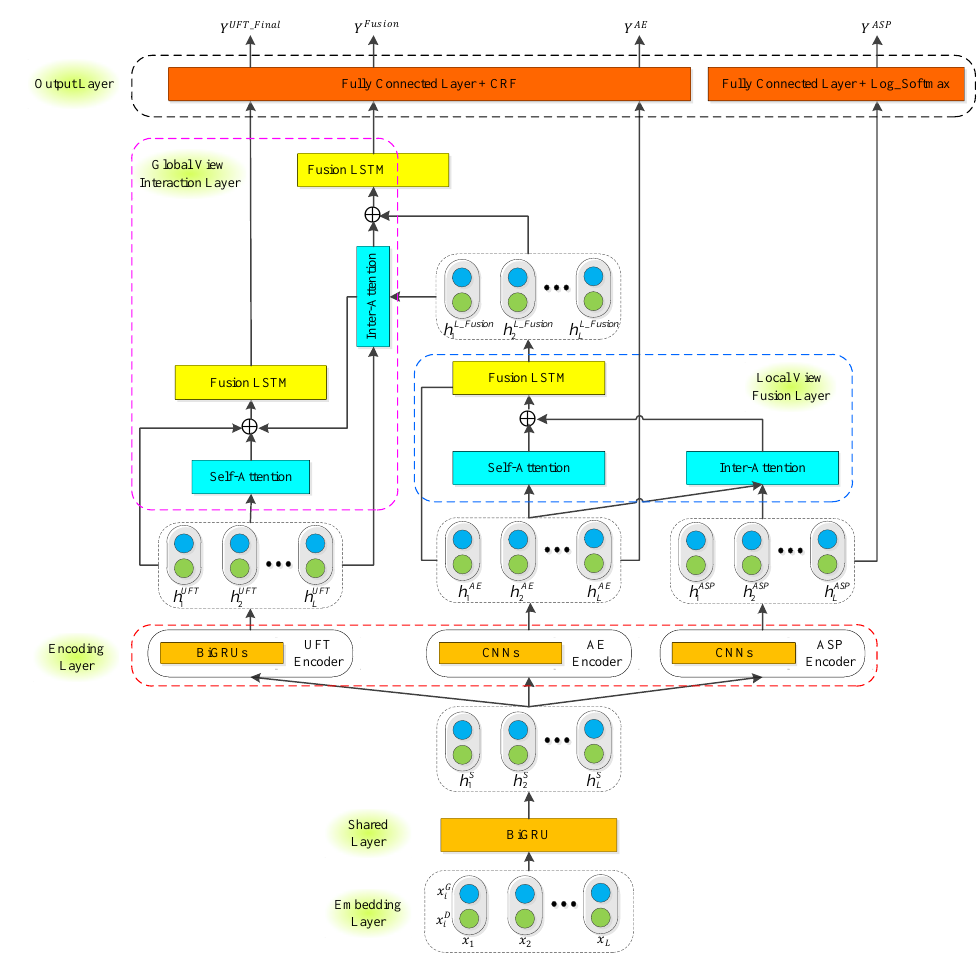
Fig. 1 Architecture of proposed MTMVN